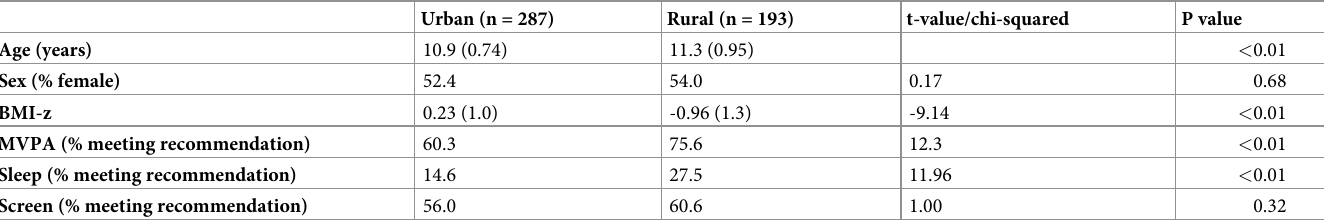
Table 1. Descriptive